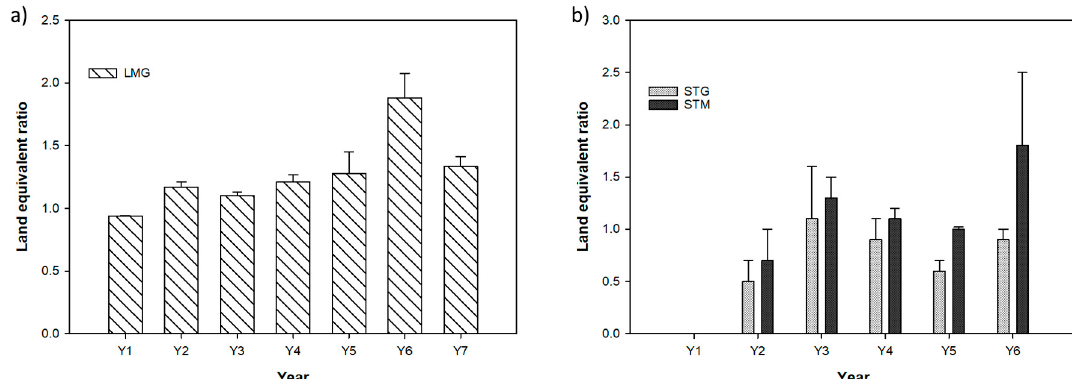
Figure 4. Land equivalent ratio (LER) of the agroforestry practices in each year of the experiment, expressed as mean and standard error (bars): ( a ) Longan–maize–forage grass (LGM); ( b ) son tra–guinea grass (STG) and son tra–mulato grass (STM).